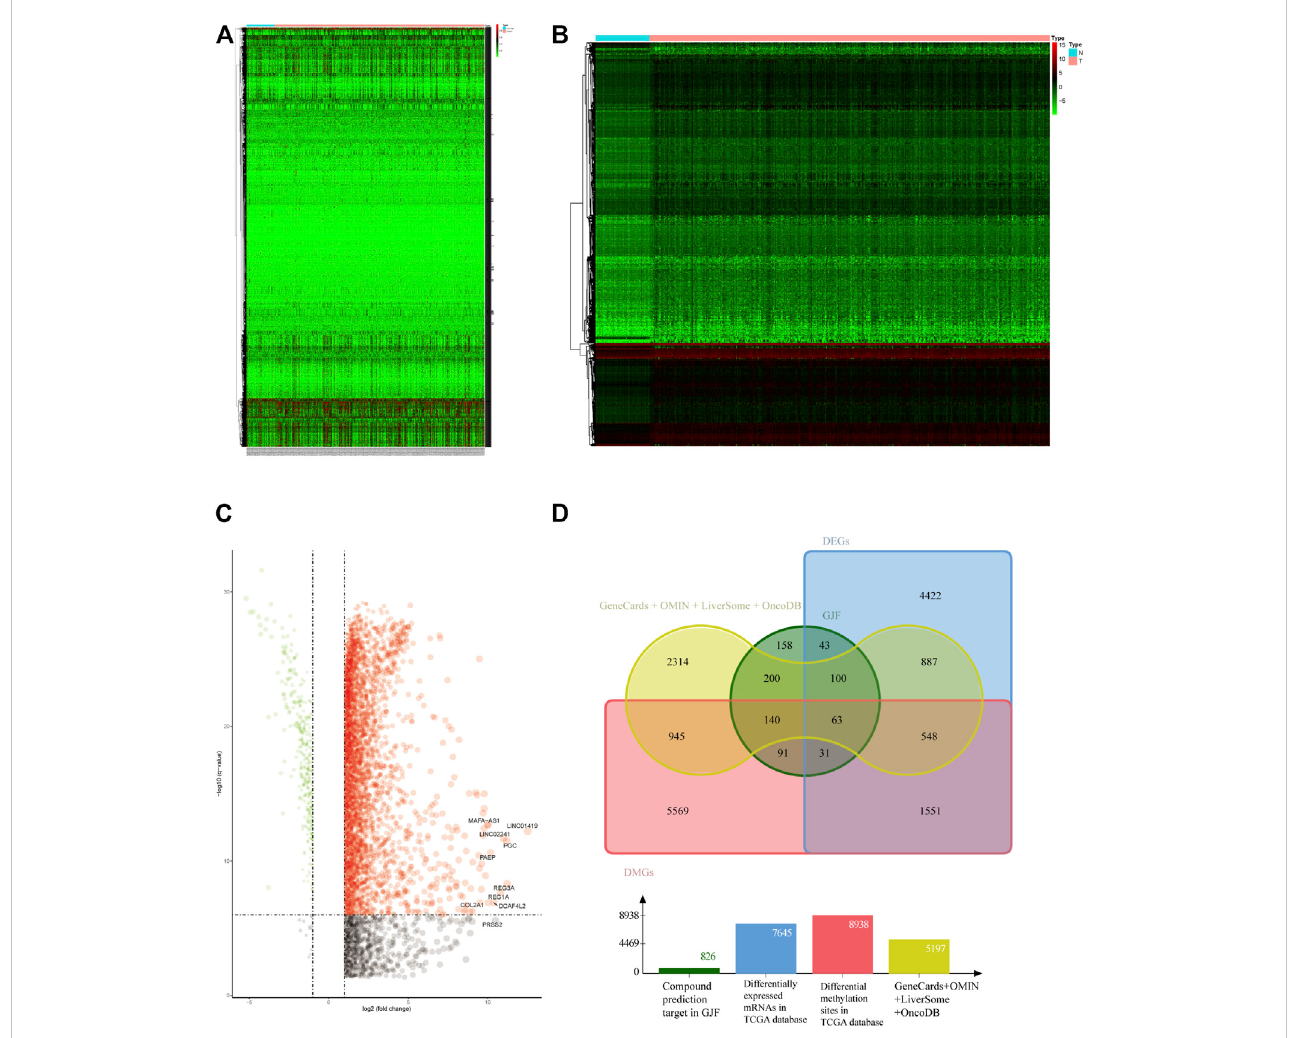
FIGURE 2 (A) Heatmap of HCC-associated differential methylation sites in the TCGA database (B) Heatmap of HCC-related differentially expressed genes in the TCGA database (C) Volcano plot of HCC-related differentially expressed genes in the TCGA (D) Venn diagram of the intersection of HCC-related targets (DEGs, differentially expressed genes; DMGs, differentially methylated